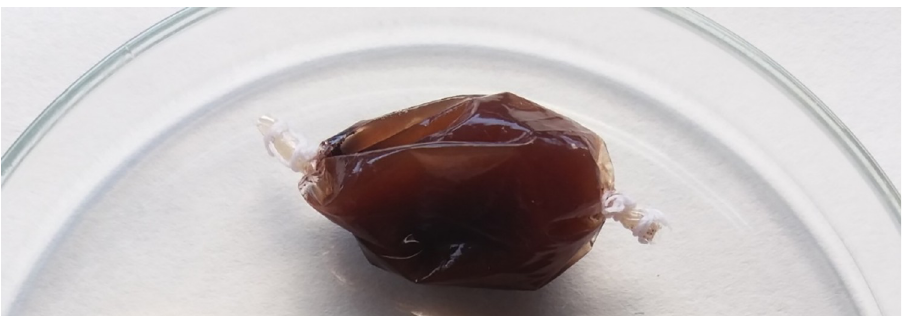
Fig 1. Semipermeable cellulose membrane capsule containing 30 mg of biosorbent per mL of deionized water (EB30).